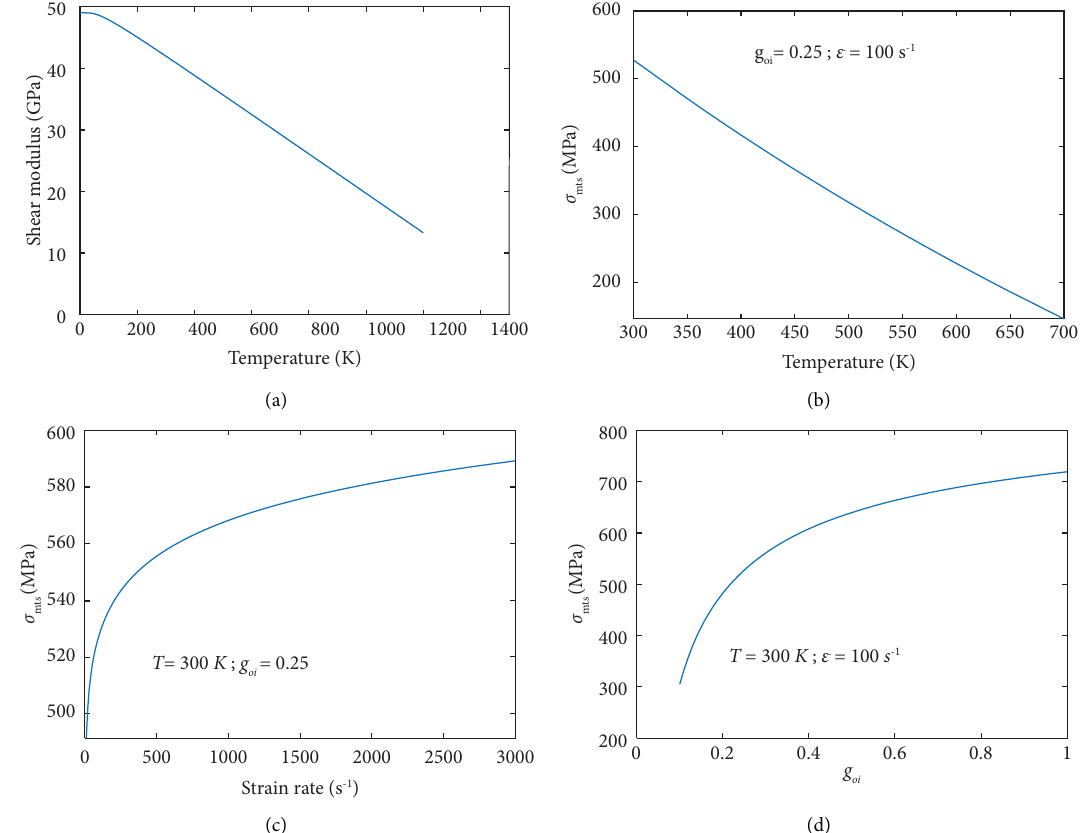
Figure 4: (a) Te variation of shear modulus with temperature and (b), (c), and (d) the efects of temperature, strain rate, and normalised thermal activation energy on thermally activated stress.